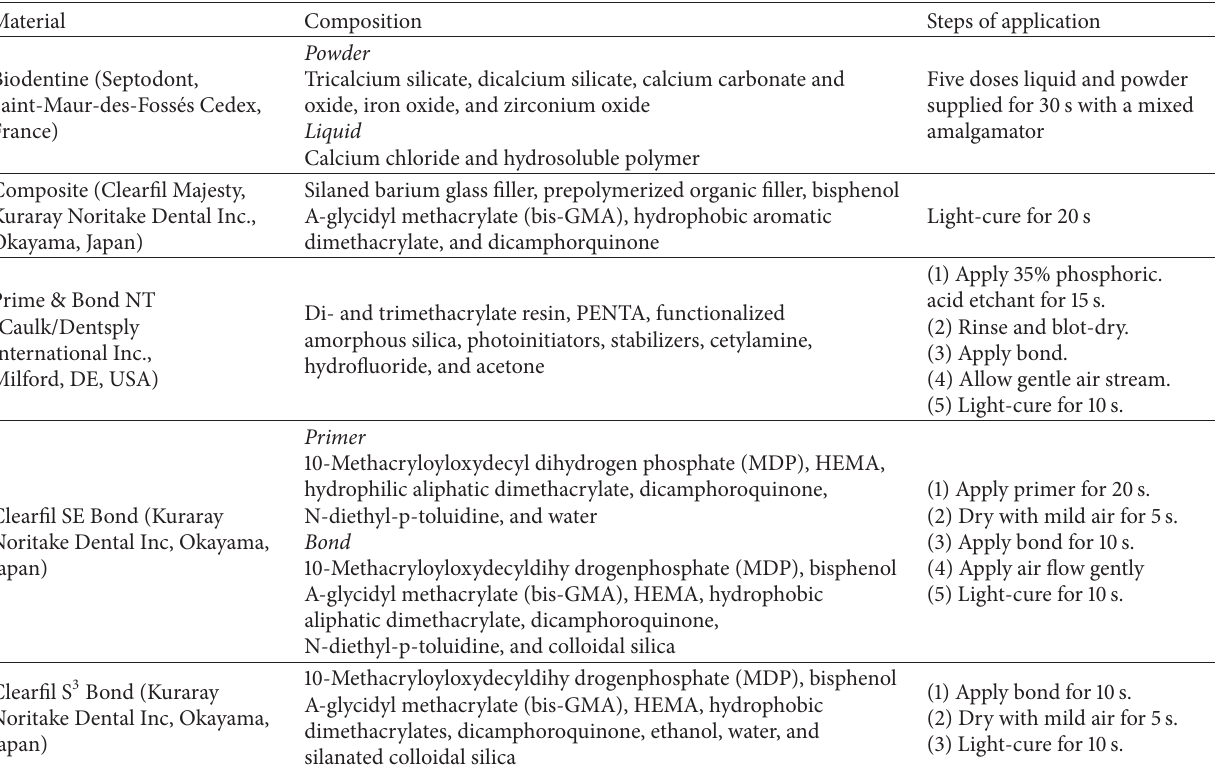
Table 1: Materials used in the